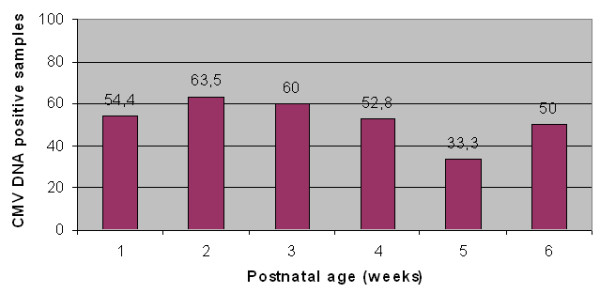
CMV DNA kinetics.